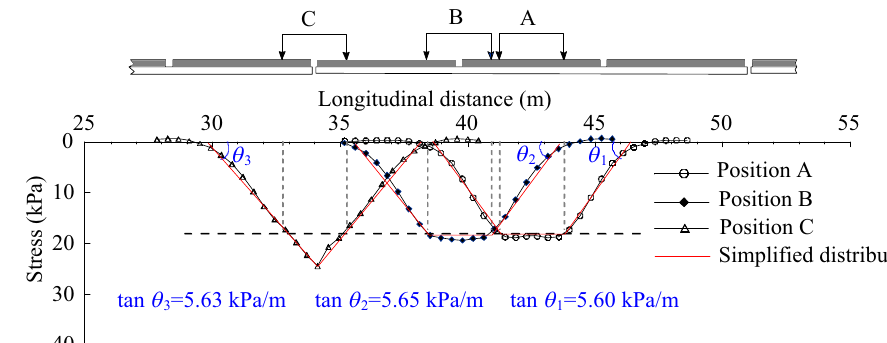
Fig. 10 Longitudinal distribution of stress on the roadbed surface after averaging transversely